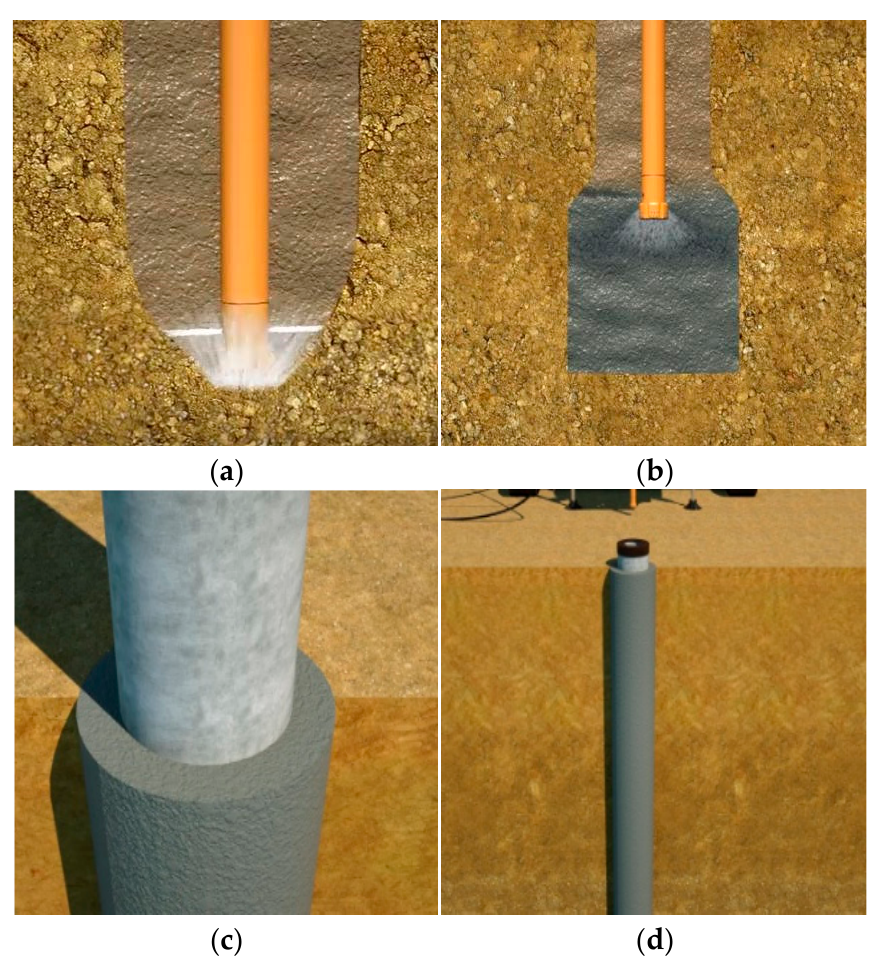
Figure 1. Technological process of the stiffened composite pipe pile: ( a ) drilling hole; ( b ) grouting for cemented soil; ( c ) implant stiffened core; ( d ) forming of the stiffened composite pipe pile.